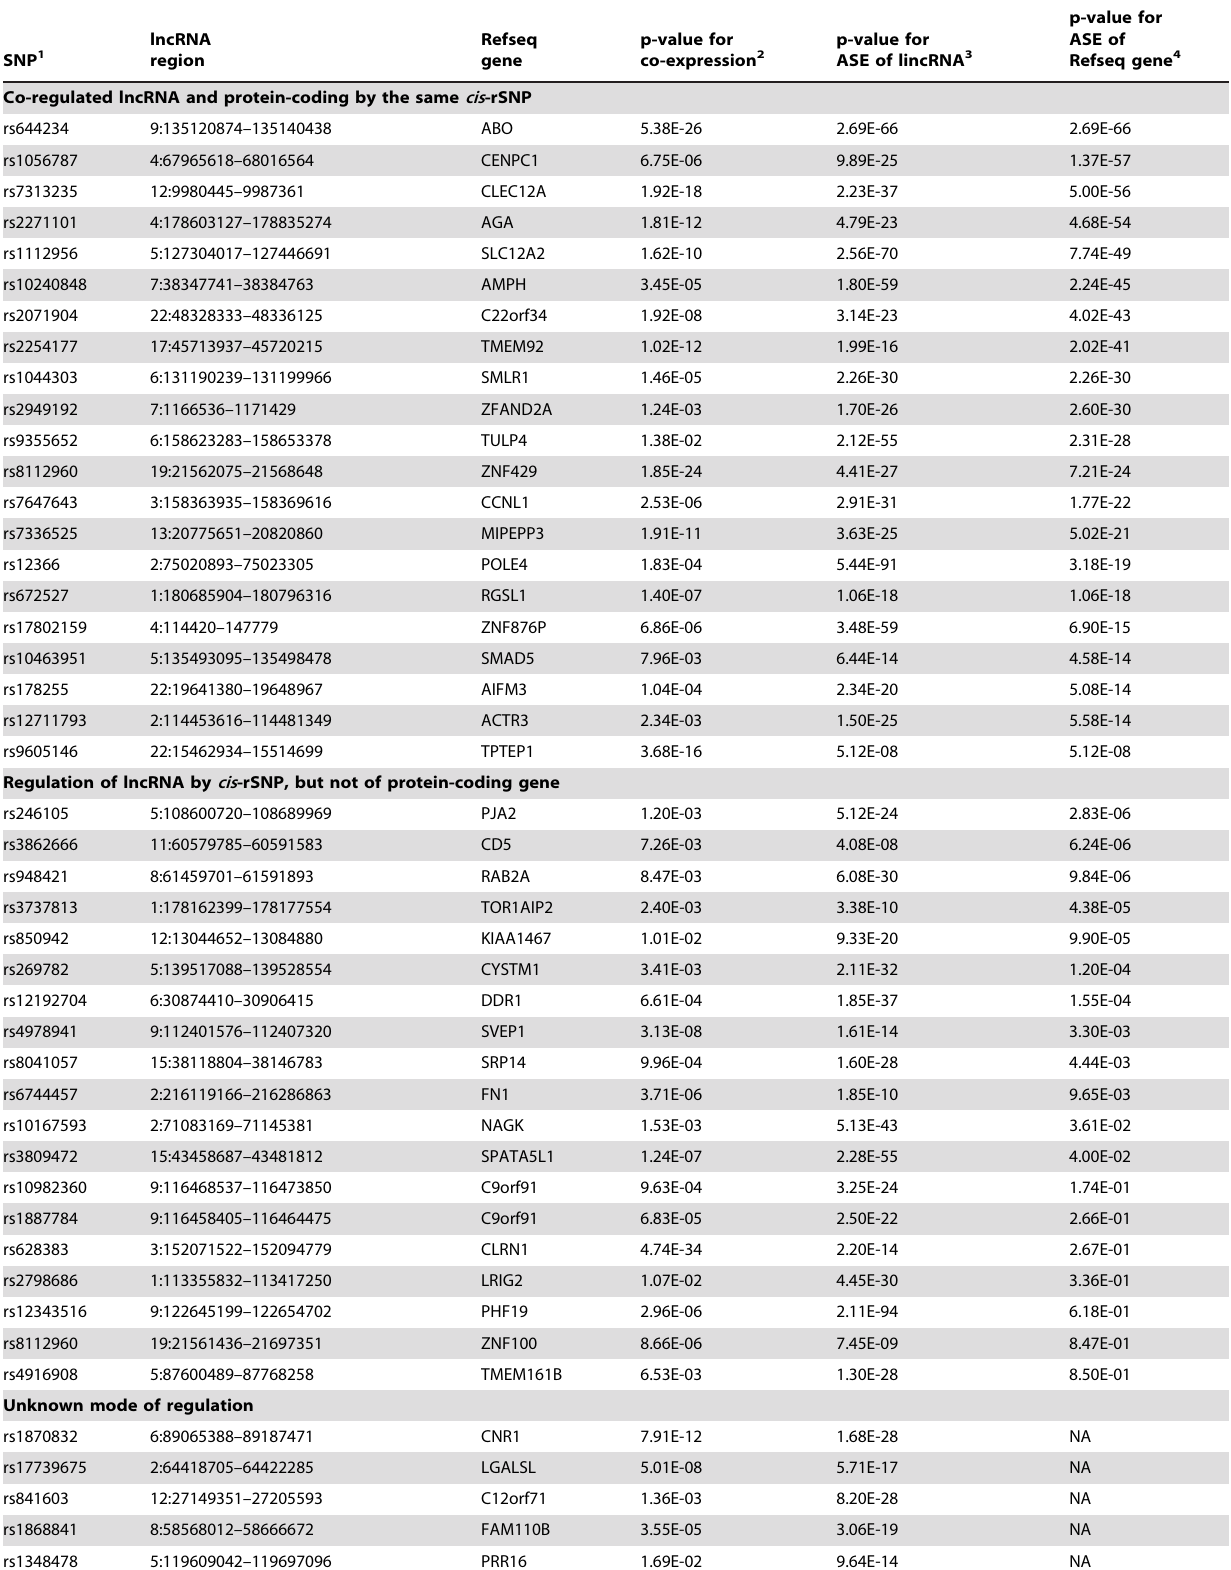
Table 1. Co-expressed lncRNA regions and protein-coding